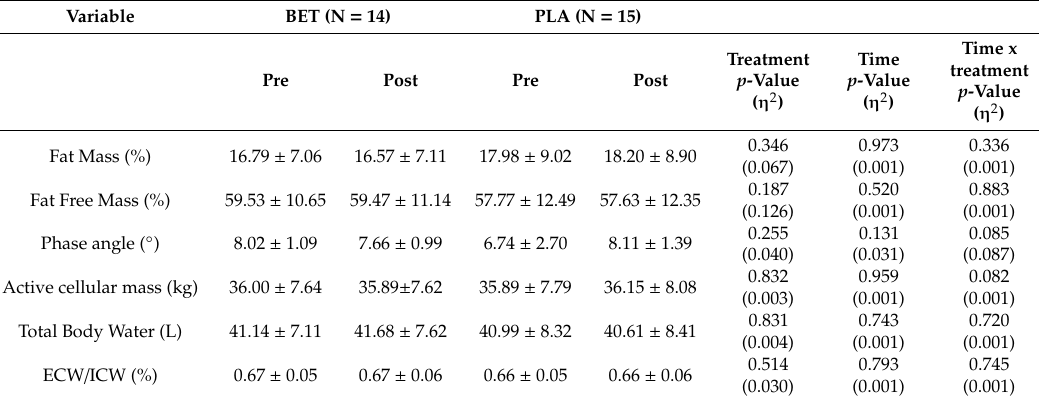
Table 2. Body composition analysis.